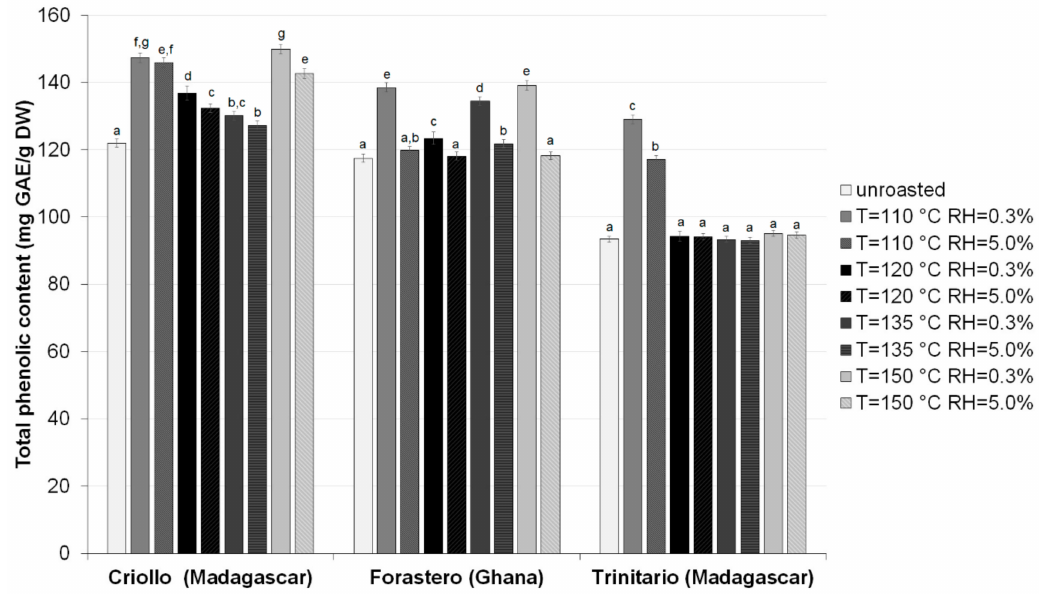
Figure 1. Total phenolics content of melanoidin fractions isolated from raw and roasted, at di ff erent at di ff erent temperatures and relative air humidities, cocoa beans of di ff erent groups. Results are presented as means ± SD from triplicate assays. Bars with the same lowercase letter (a–g) within each variety do not di ff er significantly according to Tukey’s HSD test at p <